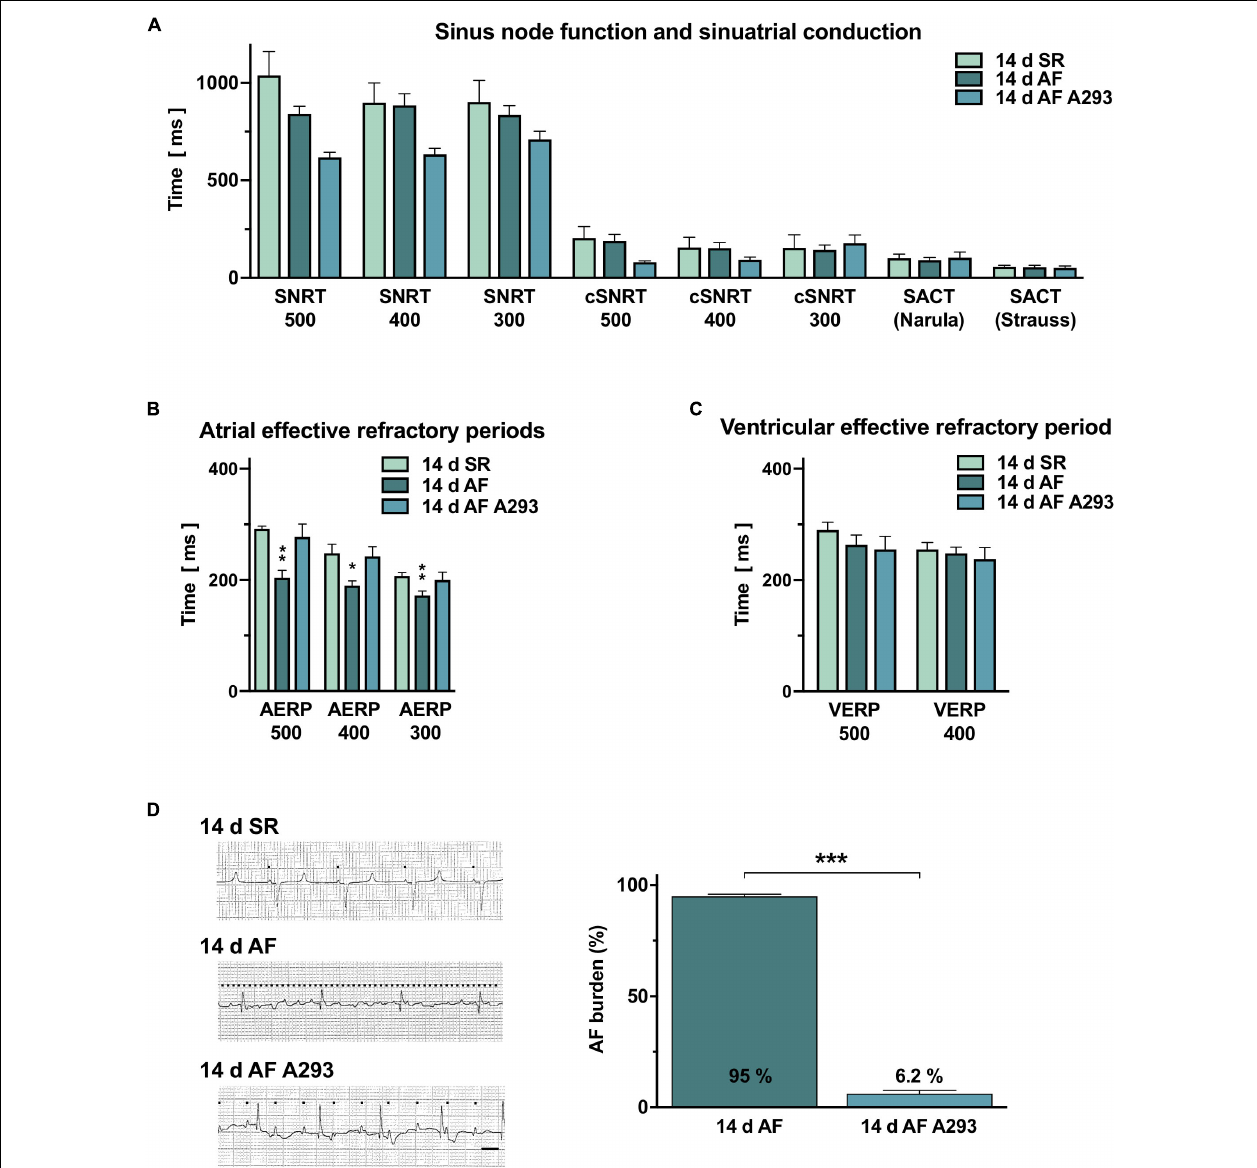
FIGURE 2 | Electrophysiological studies. (A) Sinus node recovery times (SNRTs), corrected SNRTs (cSNRTs) and sinoatrial conduction times (SACT), measured according to Strauss et al. (1973) and Narula et al. (1978) compared among the three groups (means of n = 4–5 pigs). (B) Atrial effective refractory periods (AERPs) were significantly reduced in the atrial fibrillation (AF) induction group and could be partially restored by A293 ( n = 4–5 pigs). (C) No significant differences in ventricular effective refractory periods (VERPs) were observed between the three groups ( n = 4–5 pigs). (D) Left panel: Representative surface ECG recordings from all groups on day 14 (left side). Black dots indicate P waves (scale bar, 200 ms). Right panel: AF burden (i.e., diagnosis of AF in daily surface ECGs in relation to the cumulative number of surface ECGs, documented during the 14 days treatment period) was significantly reduced by A293 treatment (means of n = 4–5 animals; error bars, SEM; * P < 0.05 vs. SR; ** P < 0.01 vs. SR; *** P < 0.001 vs. 14 days AF from Student’s t